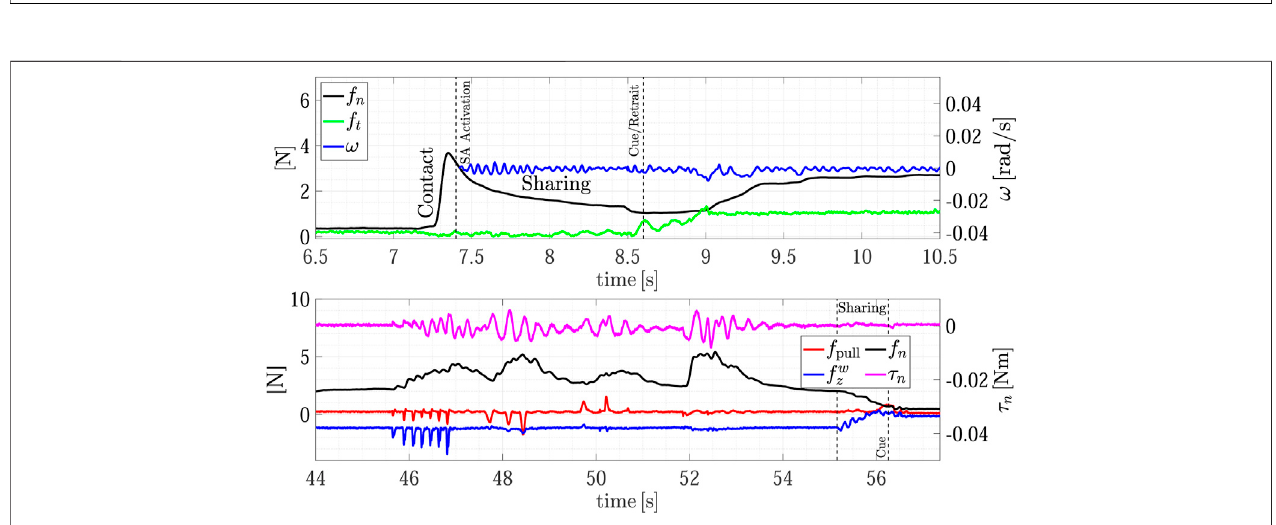
FIGURE 10 | Second experiment (Object B): detail of the H2R physical handover phase (top) ; detail of the R2H physical handover phase (bottom) .